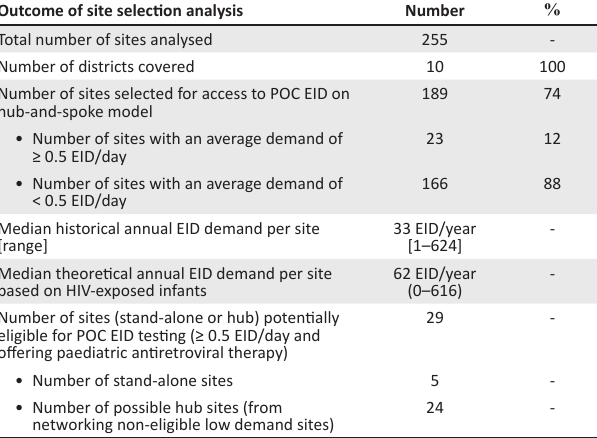
TABLE 1: Outcomes of the desk analysis for site selection and mapping for placement of HIV point-of-care early infant diagnosis using a hub-and-spoke model in Lesotho, 2016.